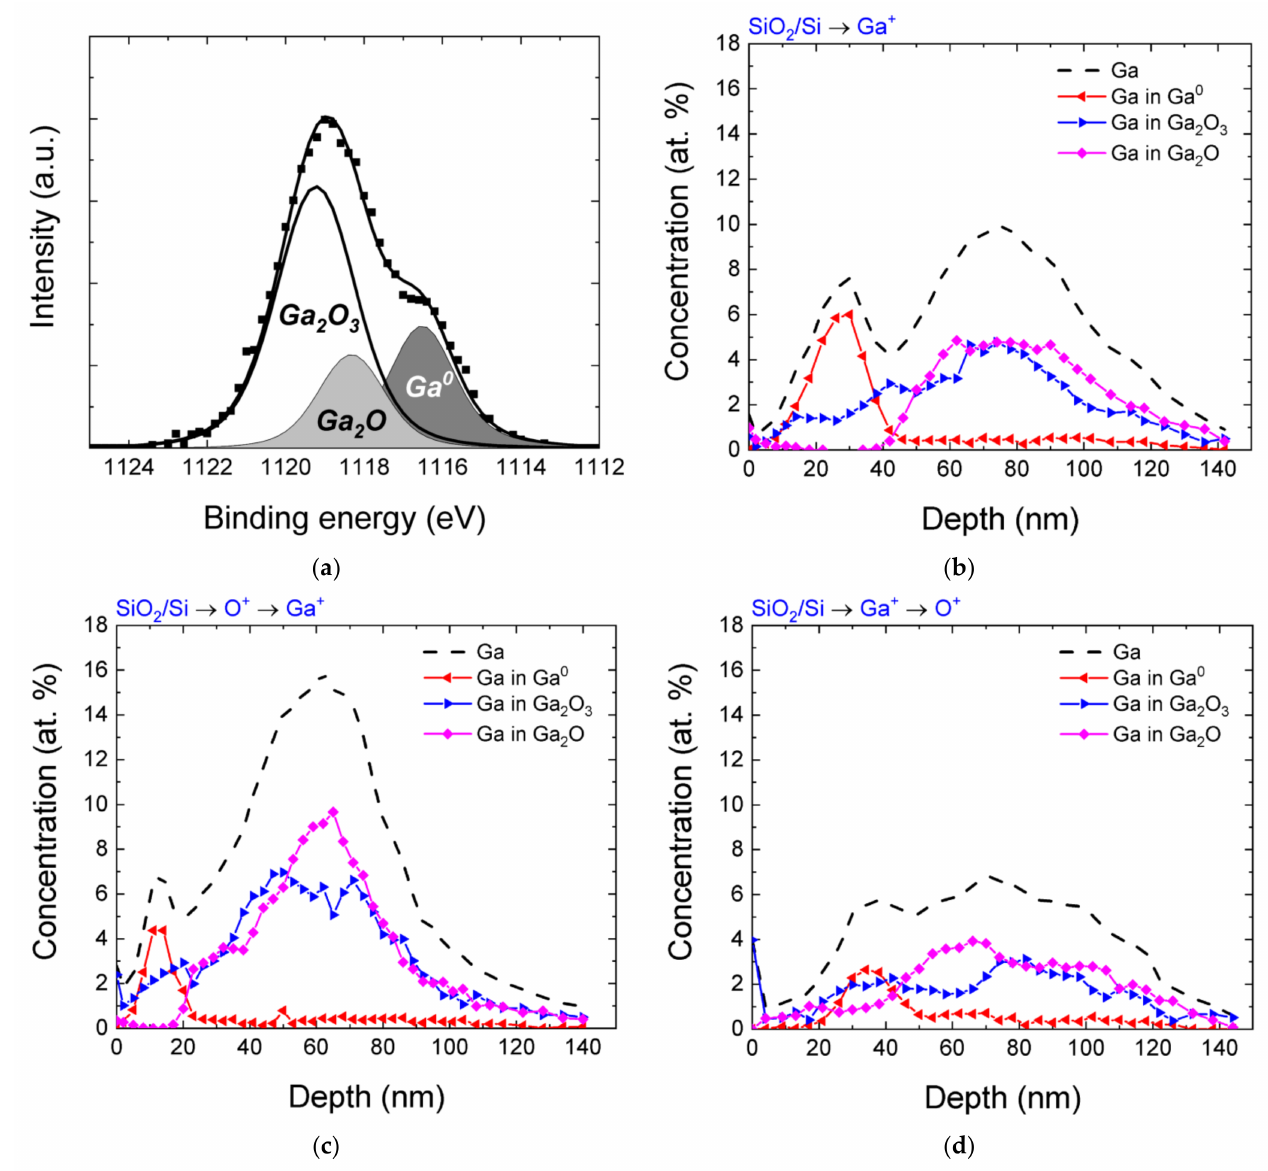
Figure 2. ( a ) An example of the decomposition of the Ga 2 p 3/2 photoelectron line; ( b – d ) depth distribution profile of gallium (dashed line), as well as gallium in different chemical states (Ga 0 , Ga 2 O 3 , Ga 2 O, colored lines) for different implantation